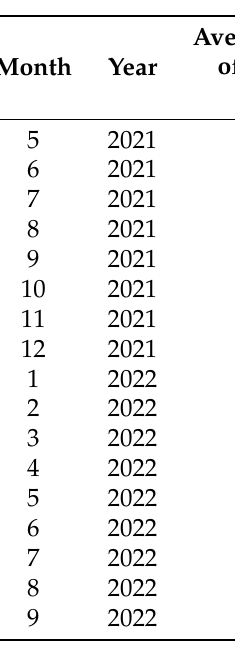
Table 2. Temperature values of treated